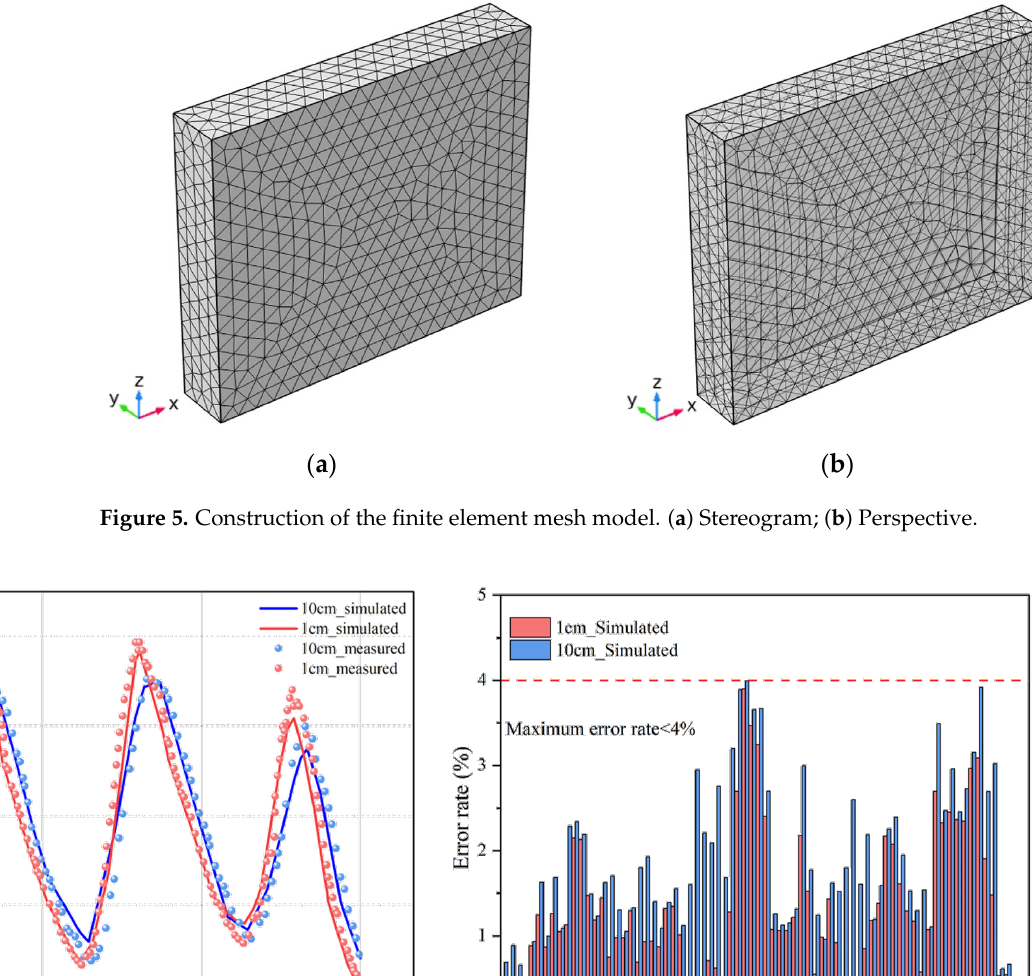
Figure 7. Cloud diagram of concrete internal temperature distribution based on the time-varying model: ( a ) center line; ( b ) corner line.